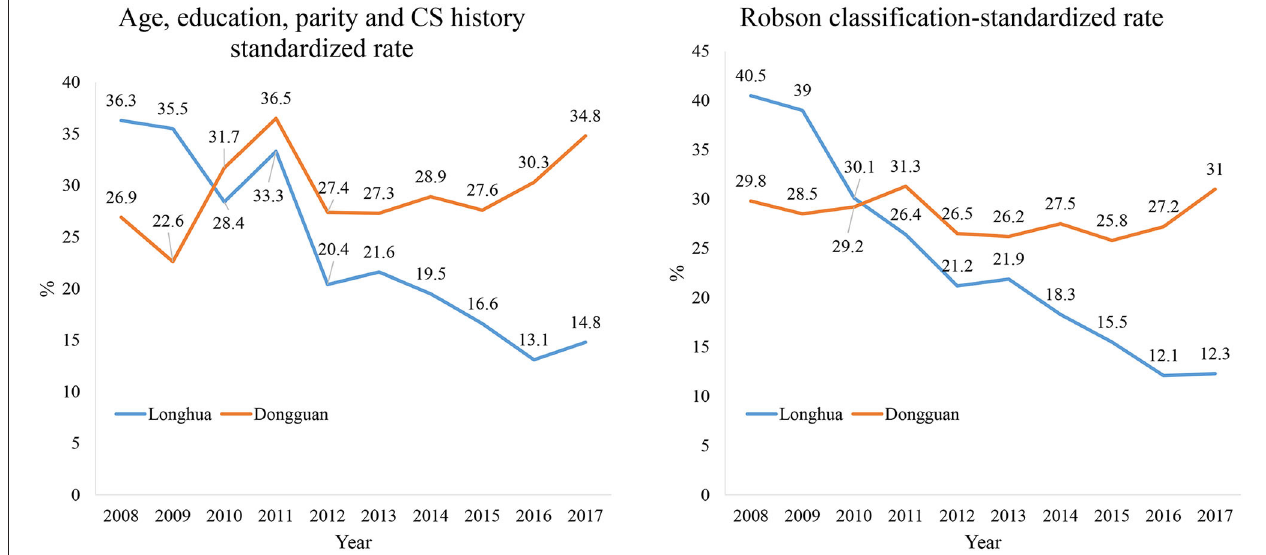
FIGURE 2 | Comparison of two hospitals in CS rate standardized for composition of age, education level, parity, and history of CS (Left) and Robson classification